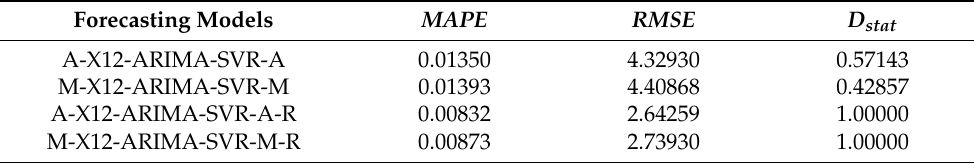
Table 3. The prediction performance of gasoline consumption in Shandong.